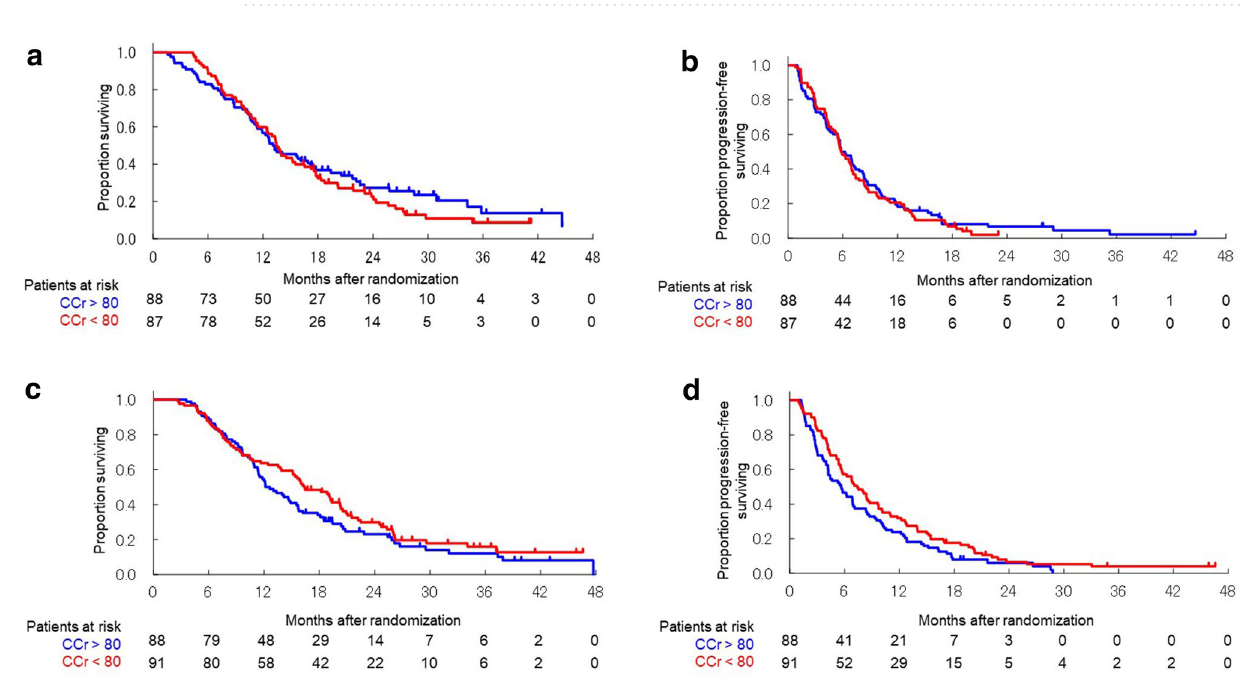
Figure 1. Comparison of overall survival and progression-free survival in each CCr group according to GC and GS arm. ( a ) Kaplan–Meier curves of overall survival in the low CCr group. ( b ) Kaplan–Meier curves of progression-free survival in the low CCr group. ( c ) Kaplan–Meier curves of overall survival in the high CCr group. ( d ) Kaplan–Meier curves of progression-free survival in the high CCr group. CCr, creatinine clearance; CI, confidence interval; GC, gemcitabine plus cisplatin; GS, gemcitabine plus S-1; HR, hazard ratio; OS, overall survival; PFS, progression-free survival.